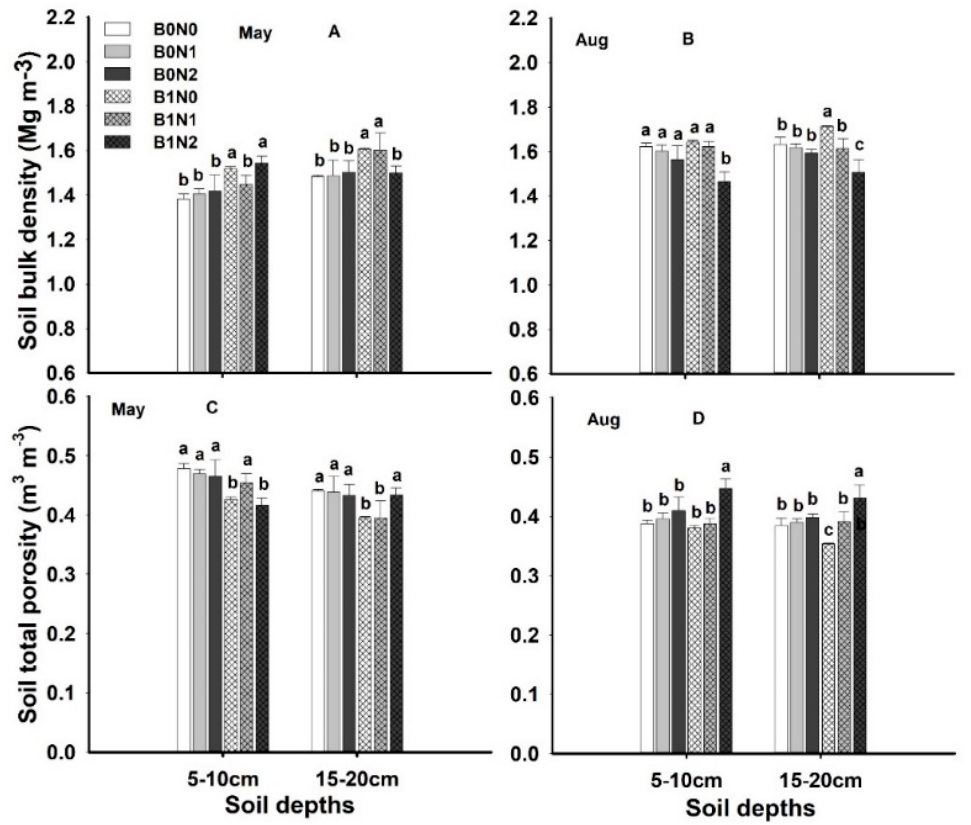
Figure 2. Effect of different treatments onsoil bulk density ( B , D ), ( A ) in May at 5–10 cm and 15–20 cm depth, ( B ) in August at 5–10 cm and 15–20 cm depth, and total soil porosity ( C ) in May at 5–10 cm and 15–20 cm depth, ( D ) in August at 5–10 cm and 15–20 cm depth. The letters a, b, c indicate statistically significant difference at p < 0.05.